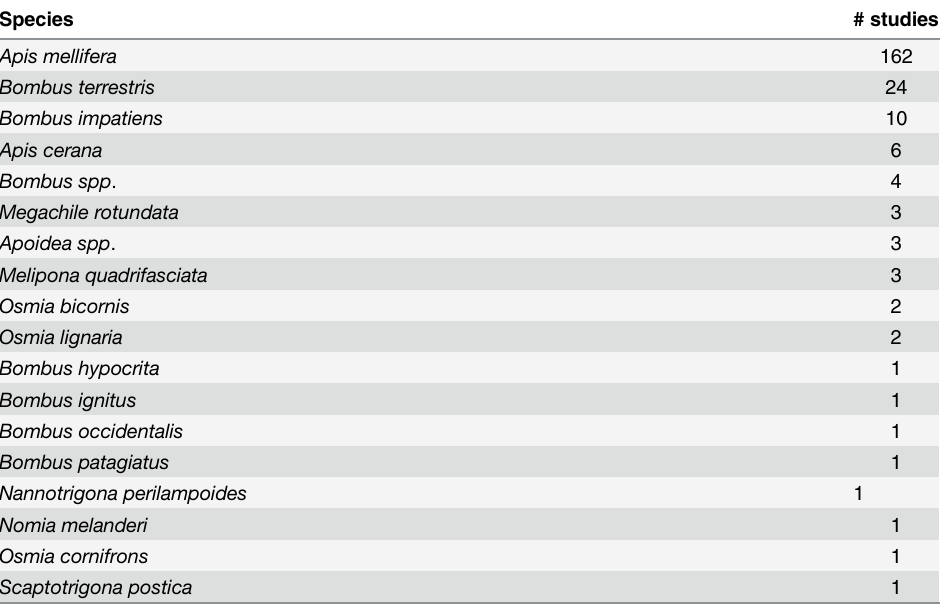
Most studies measured the effects of neonicotinoids on bees at the individual level (n = 109 studies), followed by the colony level (n = 60) and the sub-individual level (n = 48). None of the studies investigated effects on the population level according to our definitions. Table 2. Number of studies examining the effect of neonicotinoids on different bee